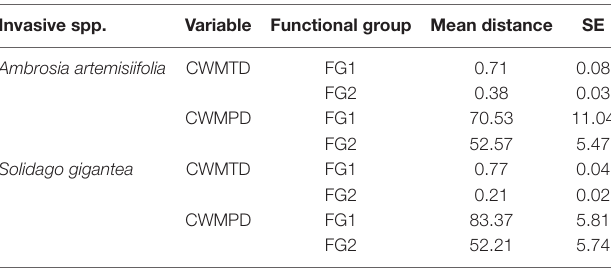
TABLE 3 | Overall native community weighted mean trait (CWMTD ± SE) and phylogenetic (CWMPD ± SE) distances calculated for the two communities (FG1,2) to both invasive alien species ( Ambrosia artemisiifolia and Solidago gigantea ). Invasive spp.